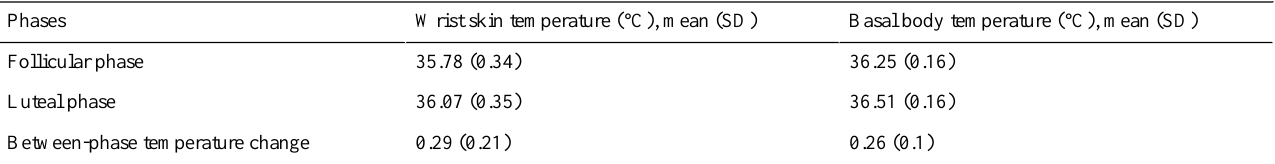
Table 3. Mean follicular and luteal phase temperatures for wrist skin temperature and basal body temperature.